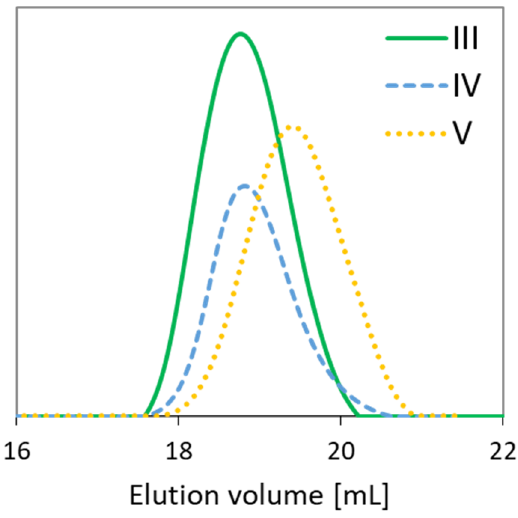
Figure 3. Gel permeation chromatography (GPC) traces of representative copolymers.